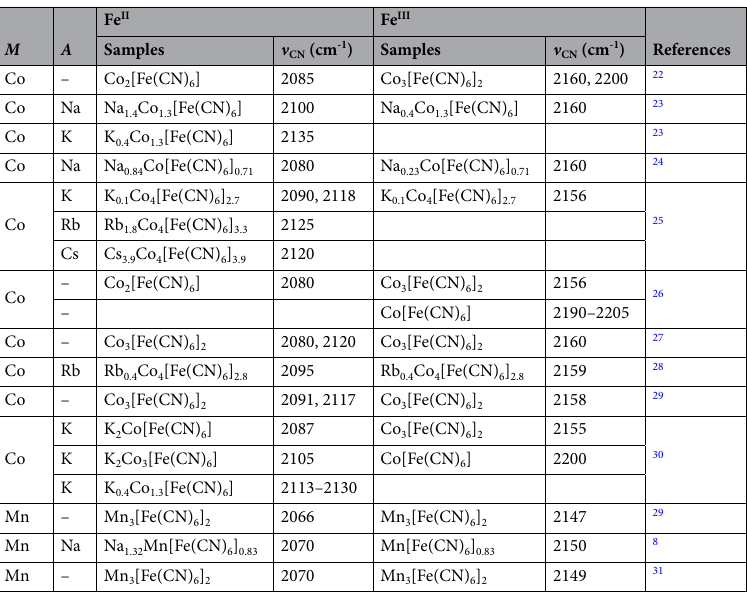
Table 1. The frequency ( ν CN ) of the CN - stretching mode in [Fe II (CN) 6 ] 4- and [Fe III (CN) 6 ] 3- in Prussian blue analogues (PBA; A x M [Fe(CN) 6 ] y